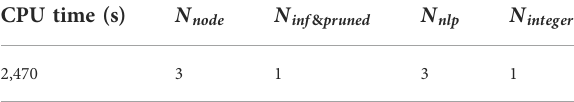
TABLE 13 Computational performance for Example